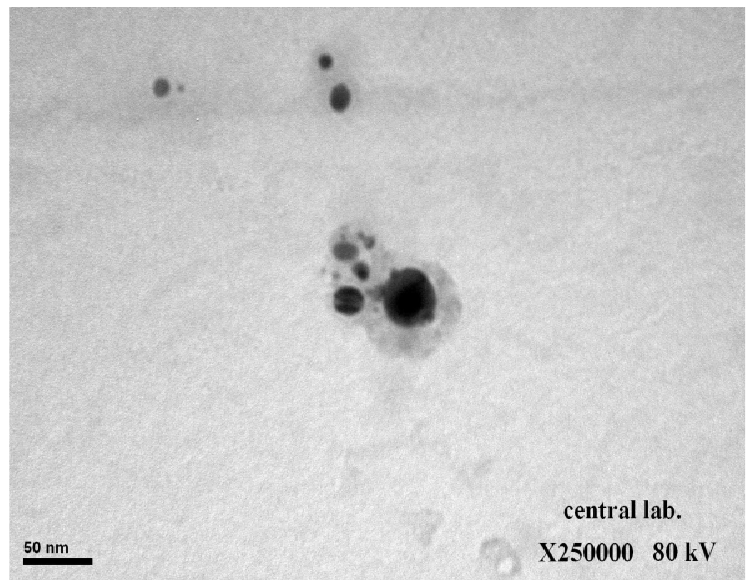
Figure 2. TEM image of the resulting AgNPs.